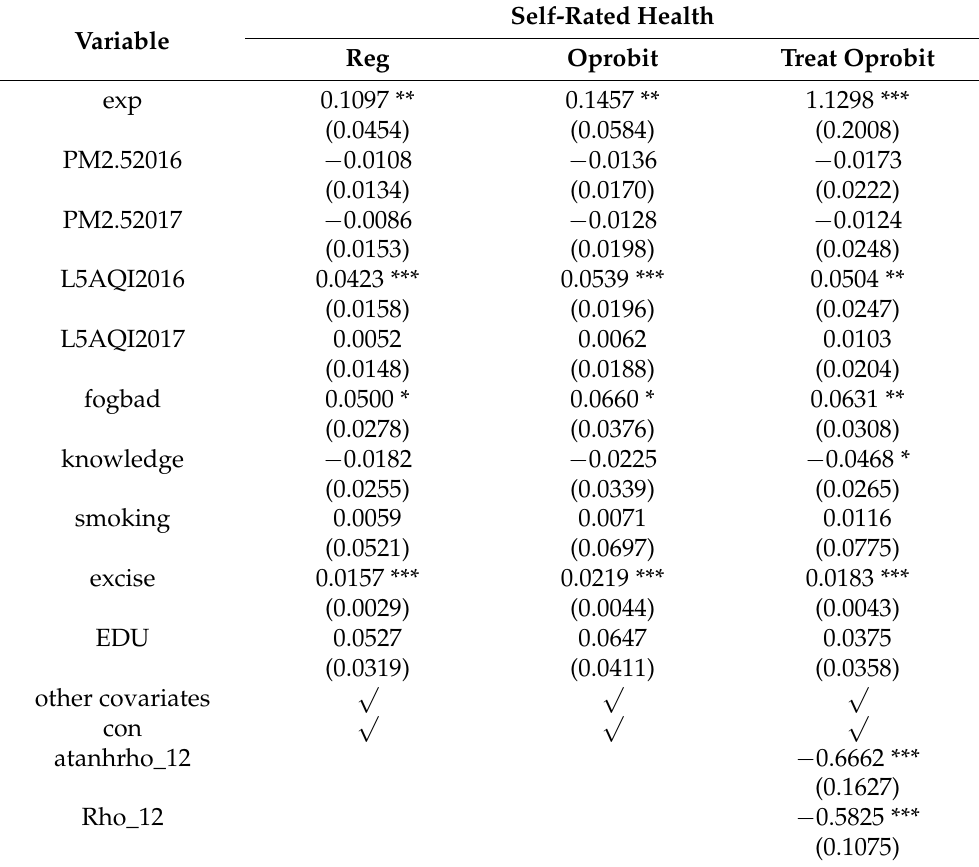
Table 5. Impact of smog avoidance investment on self-rated